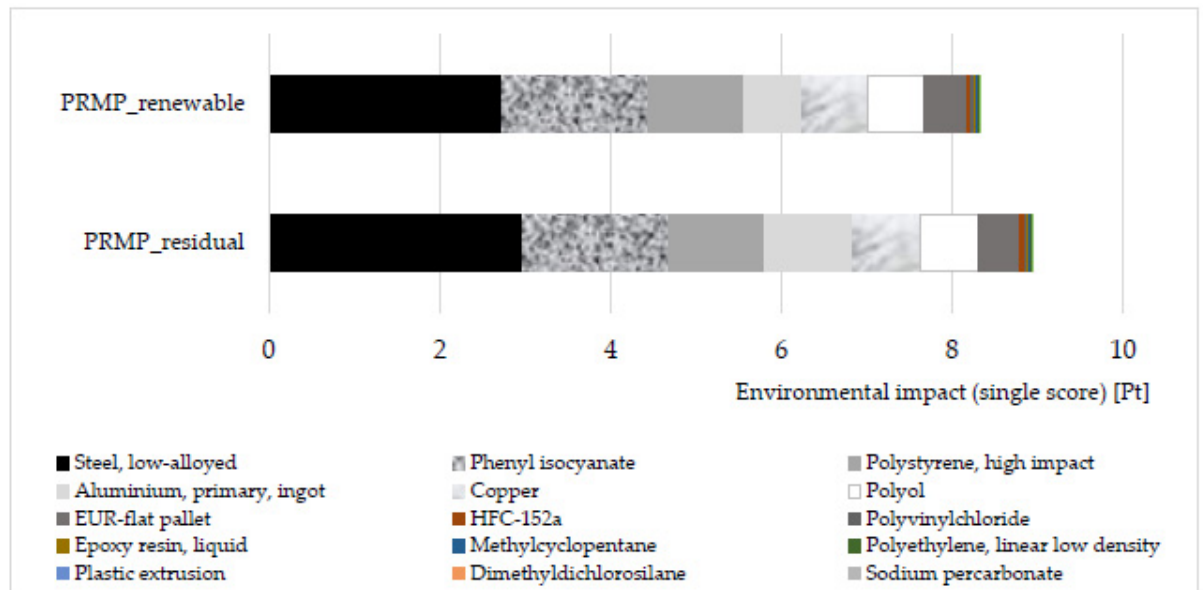
Figure 1. Environmental impact of the life cycle stage Production of raw materials and packaging (PRMP) per 1 refrigerator (8.952 Pt = residual, 8.329 Pt = renewable, decrease by 7%).